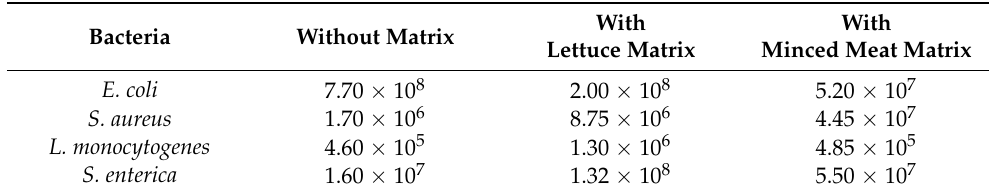
Table 4. Recovery rates values of co-culture growth in CFU/mL from BPW with and without food matrices initially inoculated at 10 3 CFU/mL.